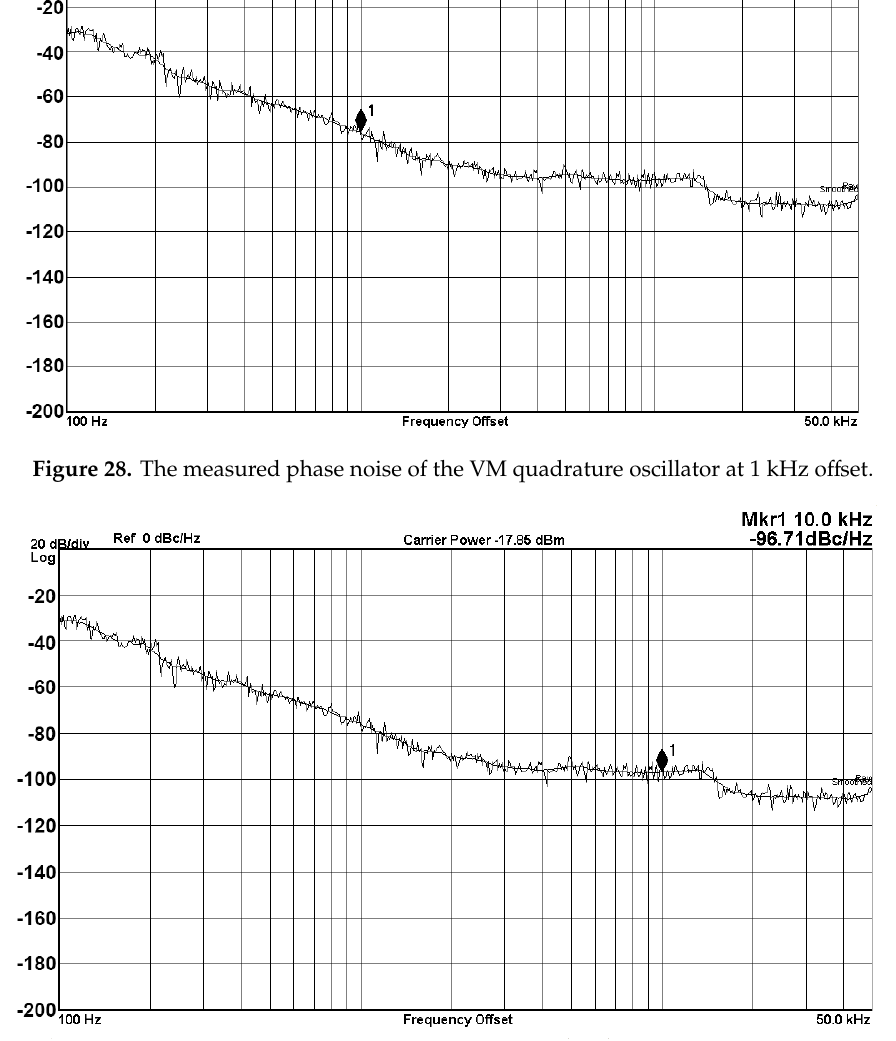
Figure 29. The measured phase noise of the VM quadrature oscillator at 10 kHz offset.